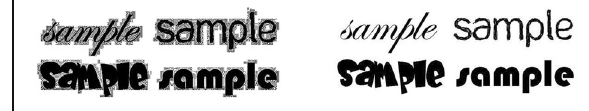
Fig. 3 Comparison of image feature